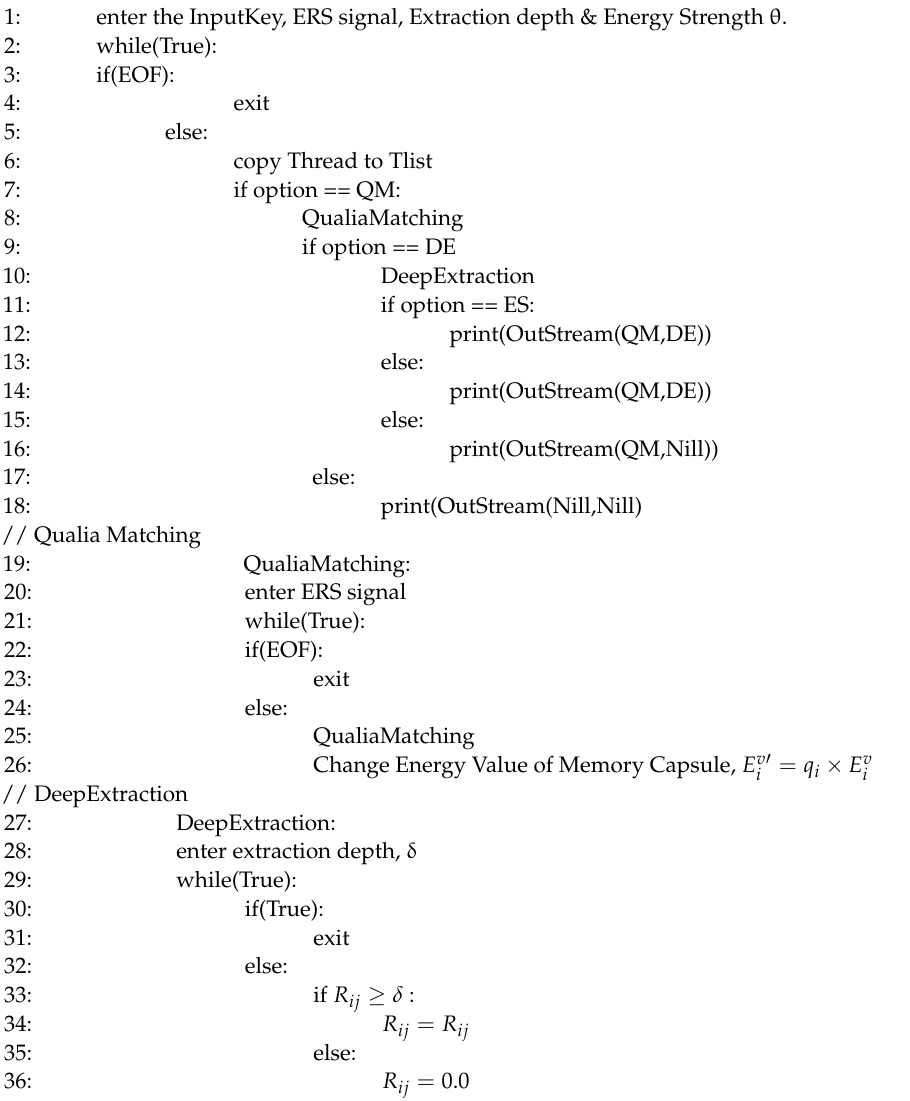
Algorithm 2: ERS Thinking Thread Extraction and